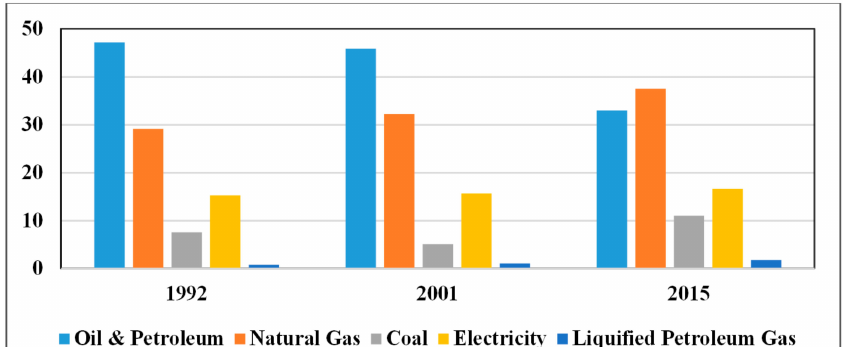
Figure 1. Historical energy fuel mix